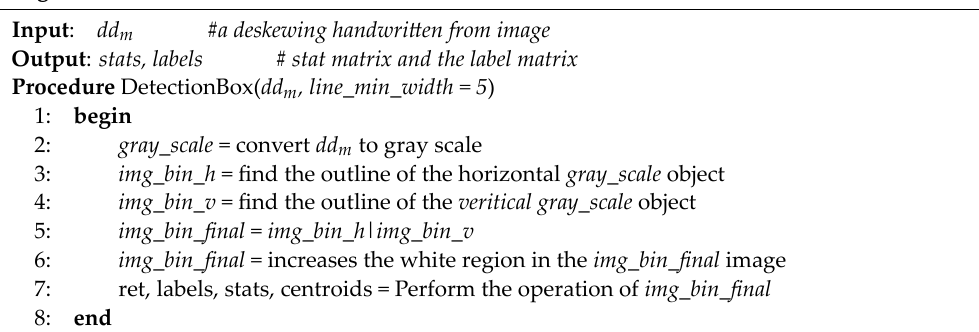
Algorithm 2: Pseudo‑code of